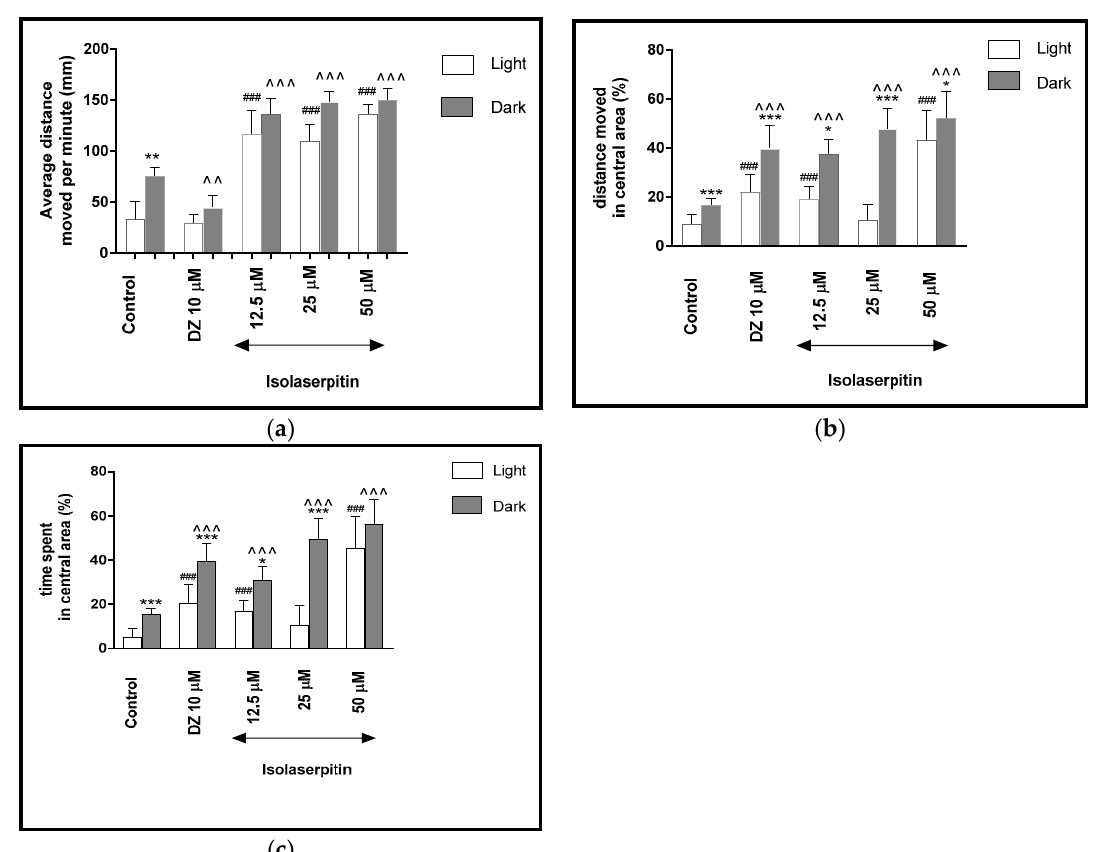
Figure 6. The effects of isolaserpitin (12.5, 25 and 50 µM) and diazepam (DZ, 10 µM) on locomotor activity during all three light–dark challenge phase. ( a ) Average distance moved by zebrafish larvae within each 1-min time bin under either light (open bars) or dark (filled bars). ( b ) The percentage of distance moved by zebrafish larvae in the central area during light phase (white bars) or dark phase (filled bars). ( c ) The percentage of time spent by zebrafish larvae in the central area during light phase (white bars) or dark phase (filled bars). Data are presented as mean ± SEM; n = 32. * p < 0.05, ** p < 0.01, *** p < 0.001 in comparison to light conditions within the same concentration group; ^^ p < 0.01, ^^^ p < 0.001 in comparison to control group under dark condition; ### p < 0.001 in comparison to control group under light condition (post hoc Bonferroni’s test).